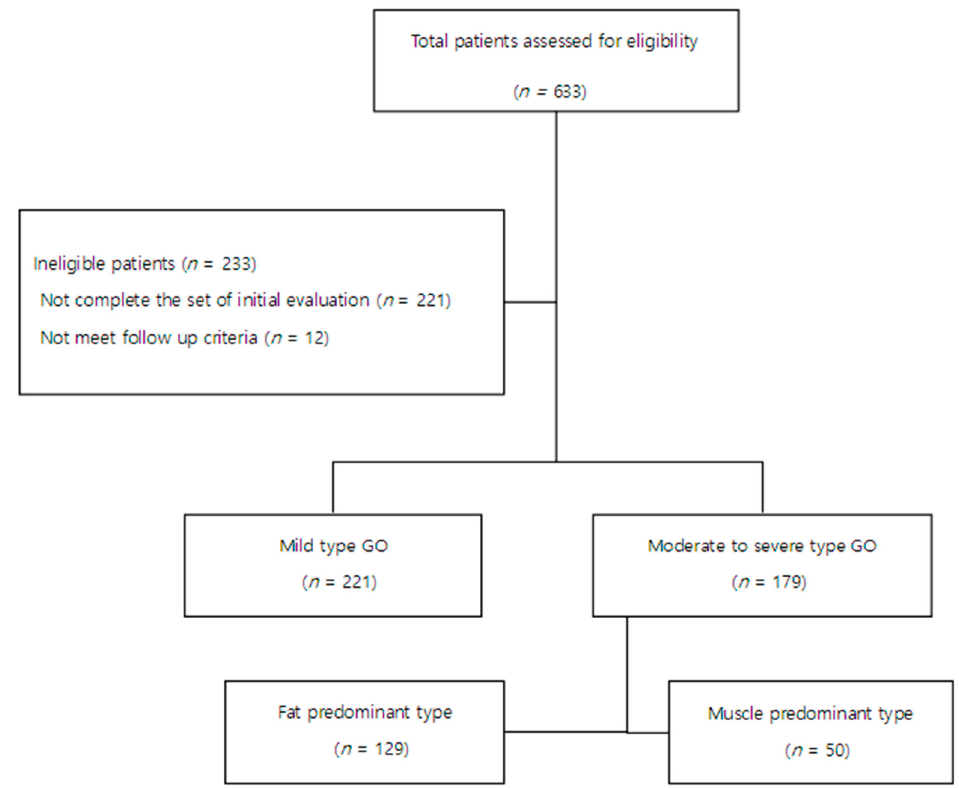
Figure 1. Flowchart showing trial profile. GD; Graves’ disease, GO; Graves’ Orbitopathy. Of the 400 patients included in the study, 221 (55.3%) were classified as having mild type disease and 179 (44.8%) as moderate-to-severe type disease requiring active treat- ment. Among the moderate-to-severe type subgroup, 129 (32.3%) were classified as fat predominant type and 50 (12.5%) as muscle predominant type. Their characteristics at initial examination are listed in Table 1. Patients who developed moderate-to-severe type GO tended to be older, had hypertension, smoking history (ex-smoker or current smoker), had normal or low serum FT4 level, and were positive for TSI. They had a higher CAS and the modified NOSPECS classification, showed higher rate of vertical and mixed eye deviation, a large amount of eye deviation, central diplopia, and had a higher ratio of cross-sectional area of inferior rectus muscle to total orbit. Patients who developed muscle predominant type GO tended to be older, male, had hypertension and autoimmune diseases, history of statin use, normal serum FT4 level, higher CAS and the modified NOSPECS classification, presented higher rate of eye deviation, a large amount of eye deviation, central diplopia, and a higher ratio of cross-sectional area of inferior rectus muscle and lower ratio of cross-sectional area of lateral rectus muscle to total orbit than patients with fat predominant type.